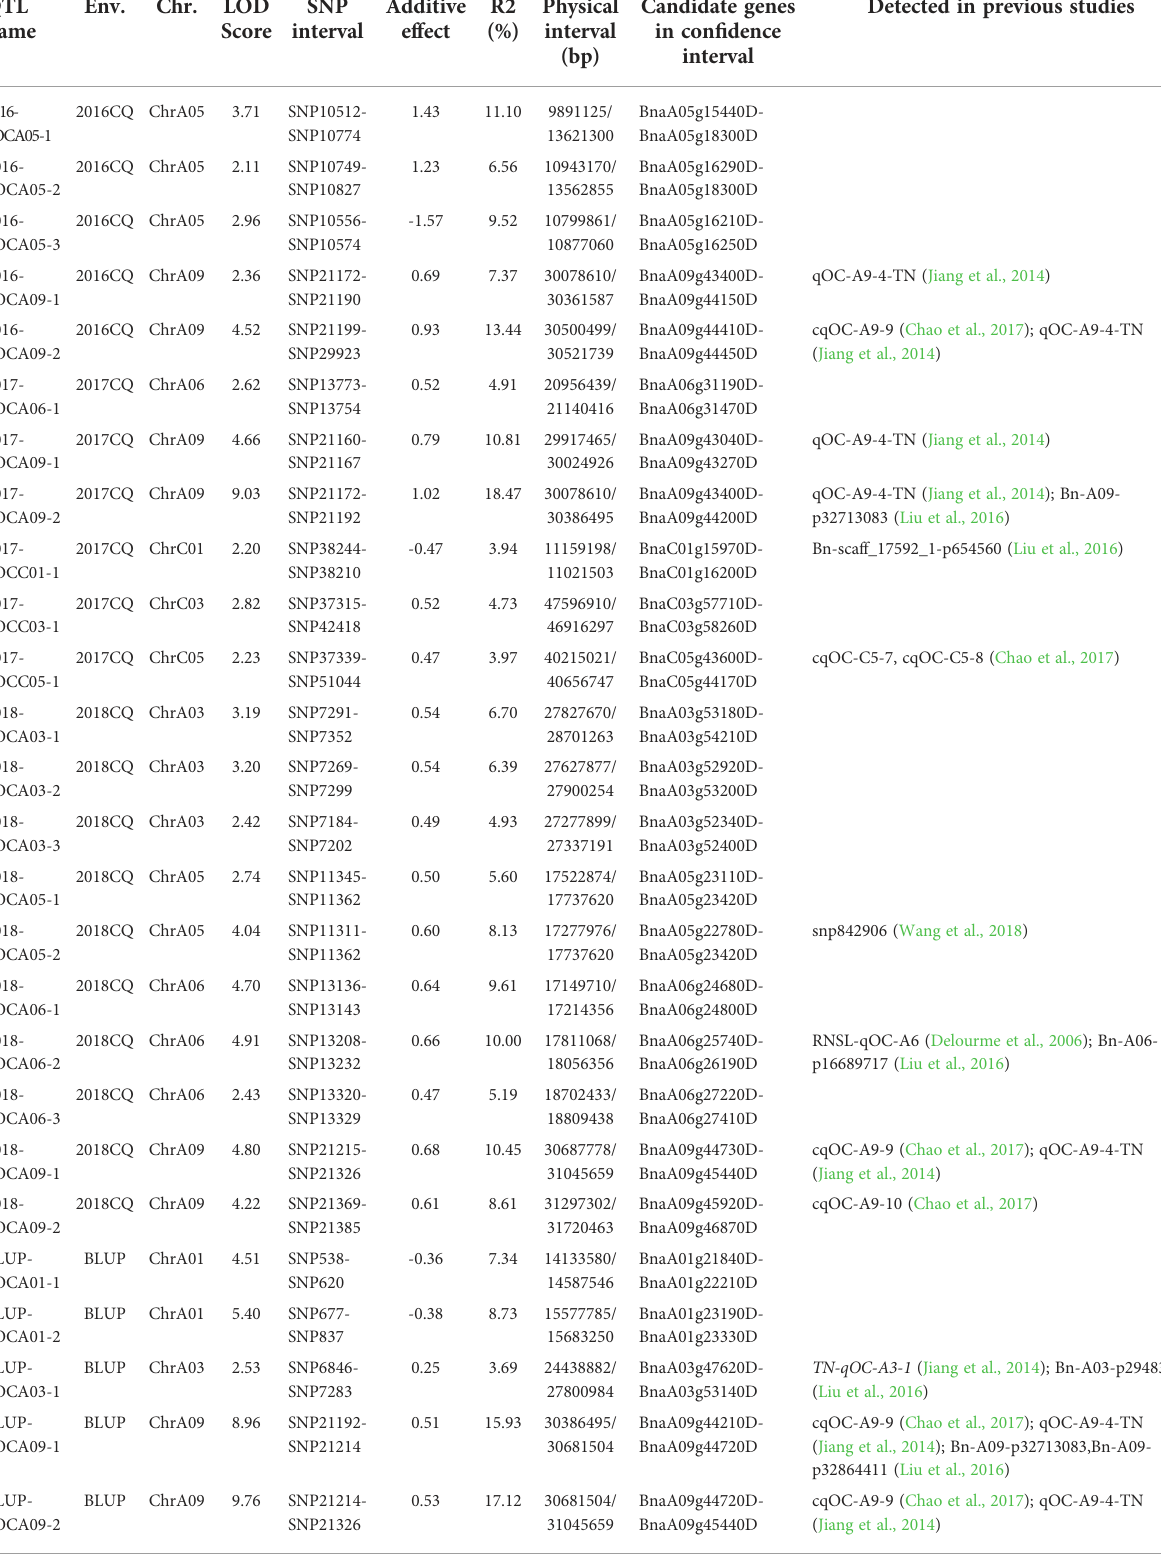
TABLE 3 QTL for seed oil content (SOC) detected from the RIL population in three